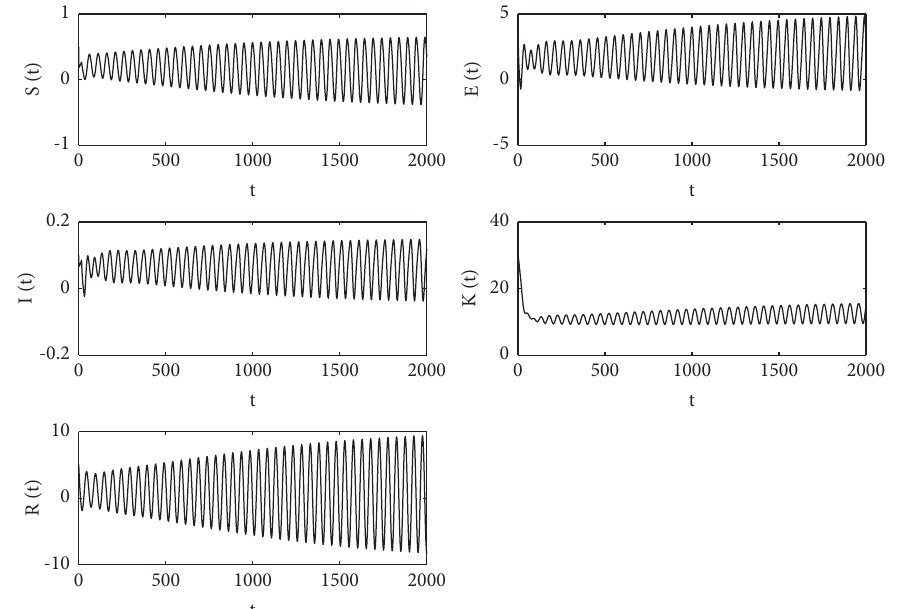
Figure 6: Phase portrait of fractional system (4). When τ asymptotically